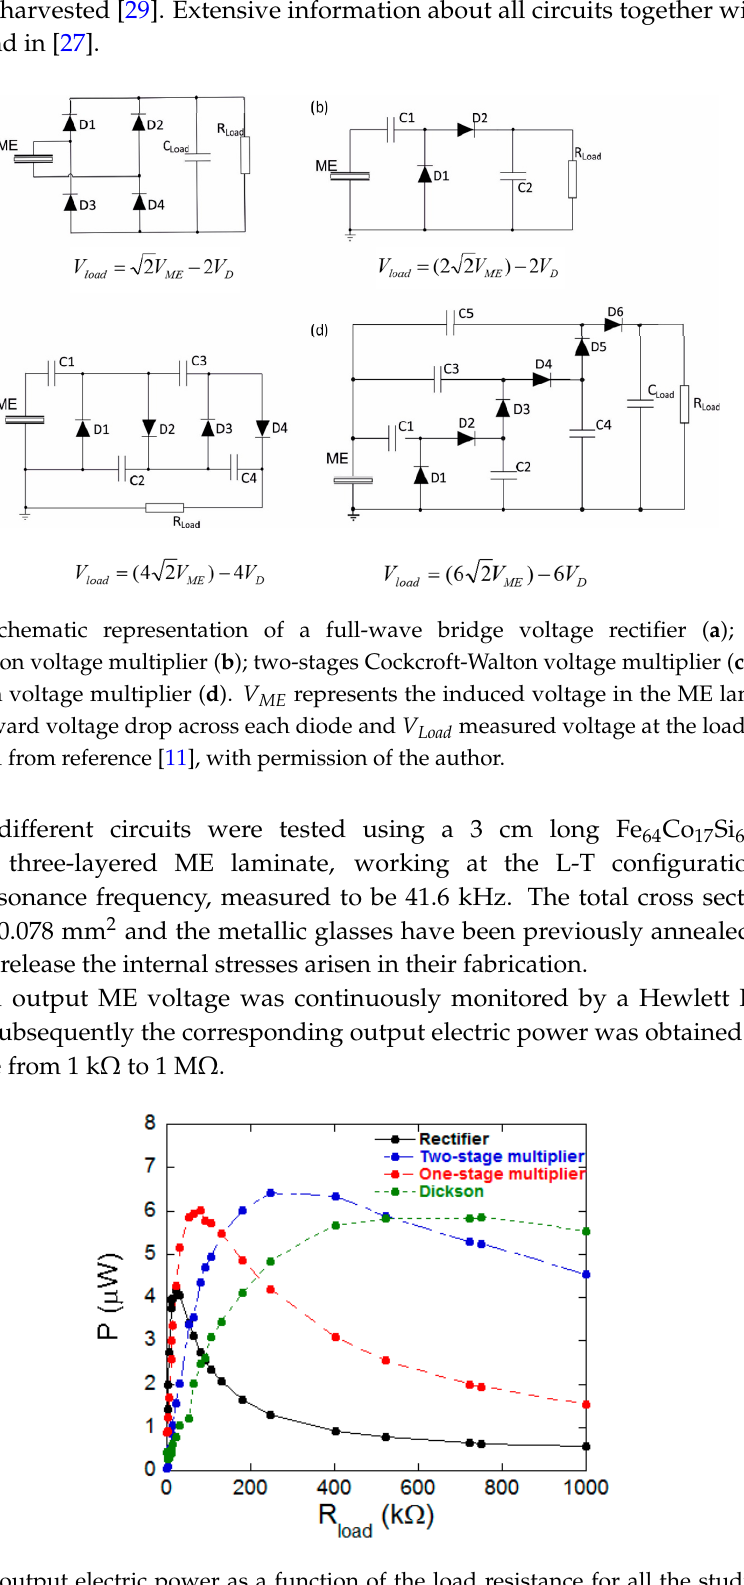
Figure 7. The output electric power as a function of the load resistance for all the studied energy harvesting circuits.